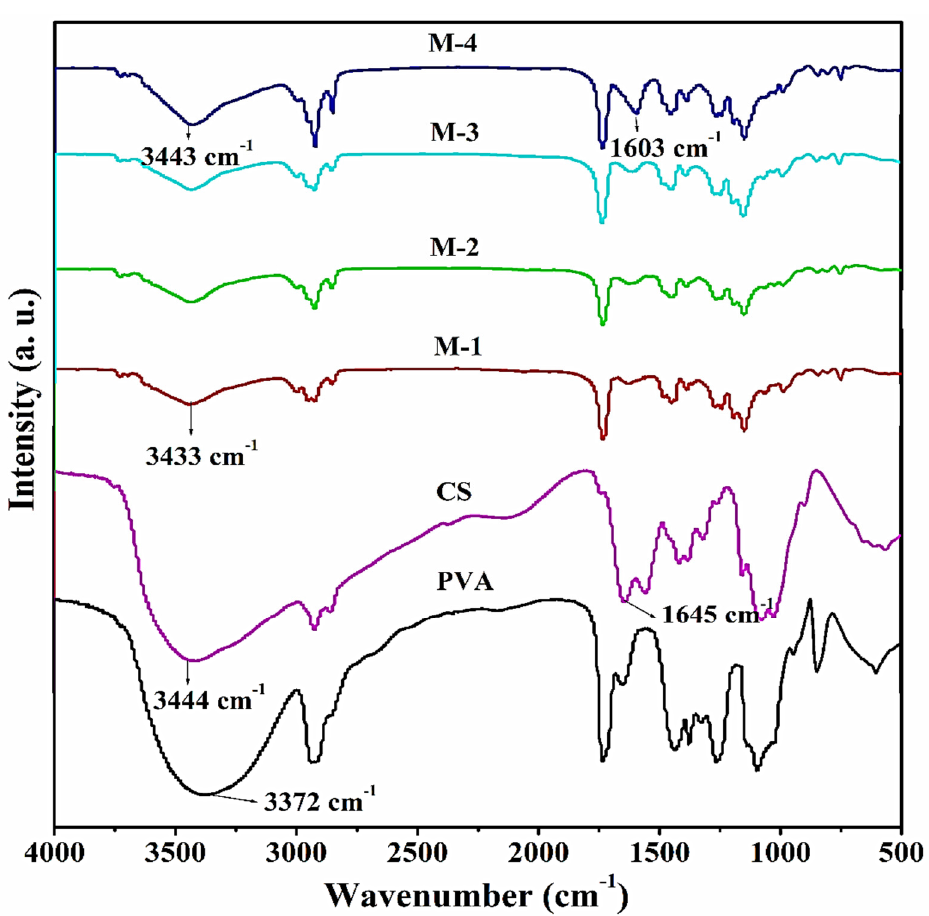
Figure 1. FTIR spectra of pure PVA, Chitosan, CS-capped AgNPs incorporated hybrid PVA mem- branes: (M-1) 0.5 wt.%; (M-2) 1 wt.%; (M-3) 1.5 wt.%; (M-4) 2 wt.% of CS-capped AgNPs.